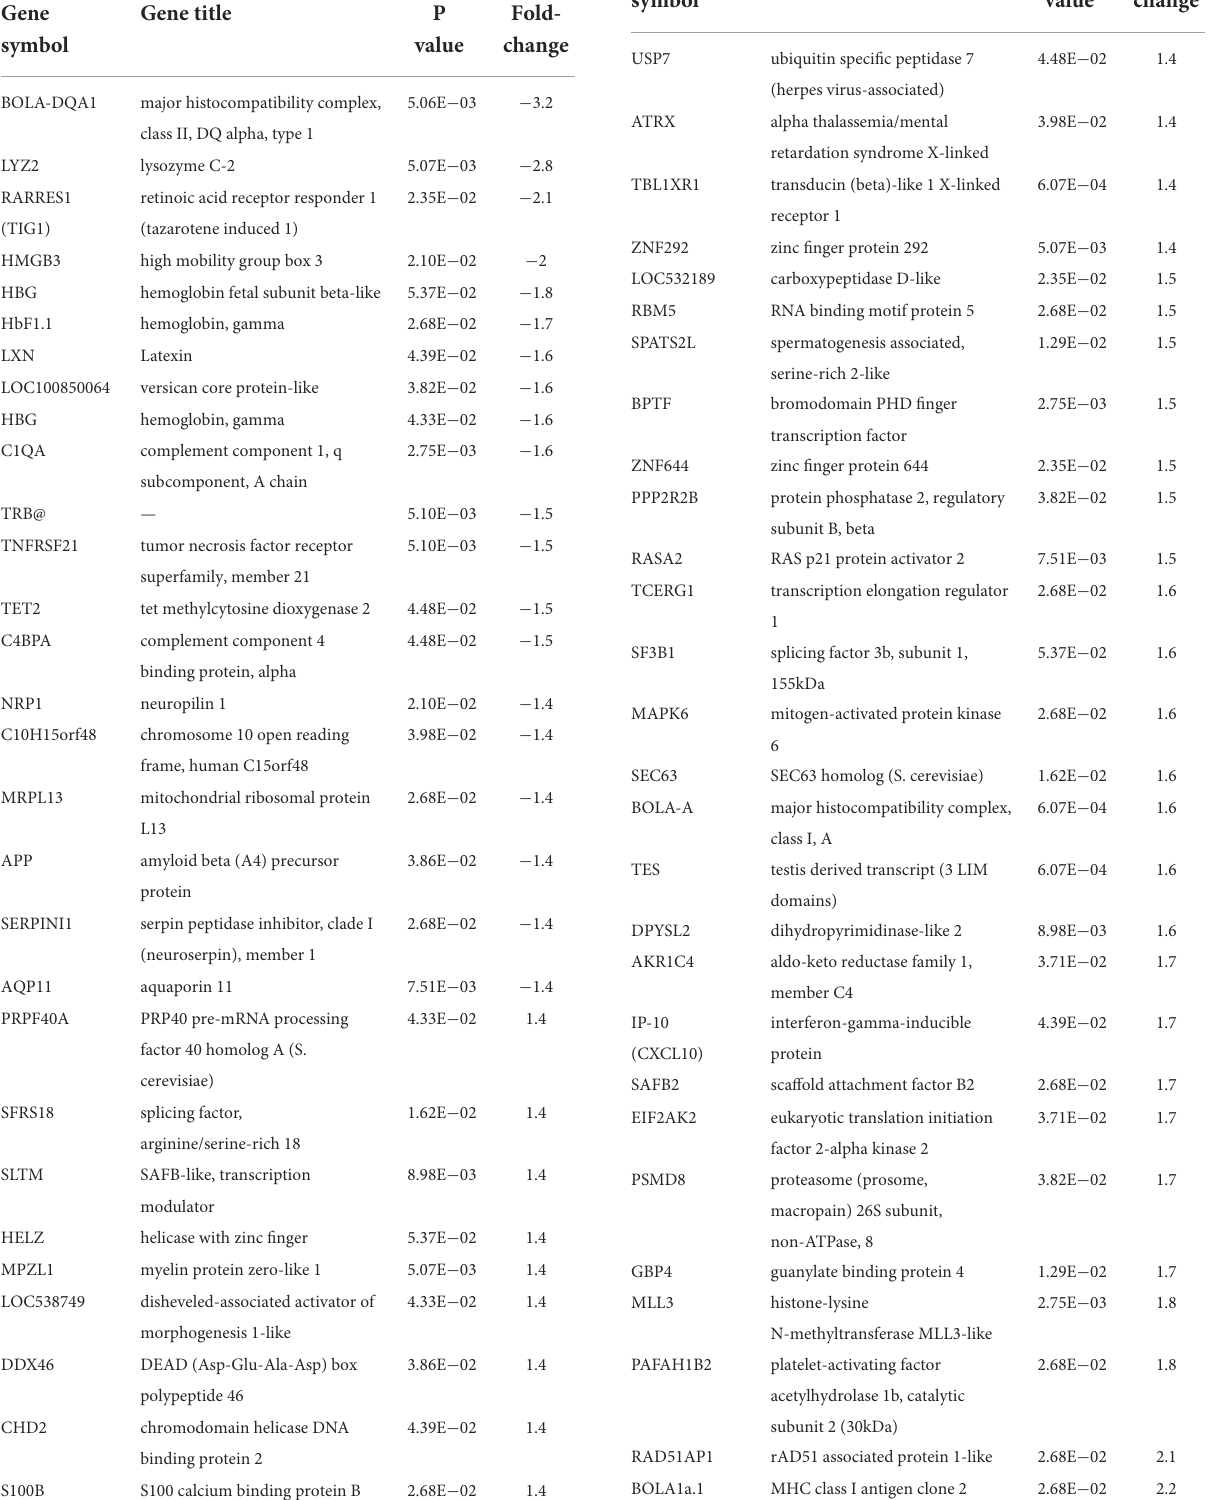
TABLE 3 Genes differentially expressed in the Non-Infected vaccinated sheep (protected) compared to the Infected vaccinated